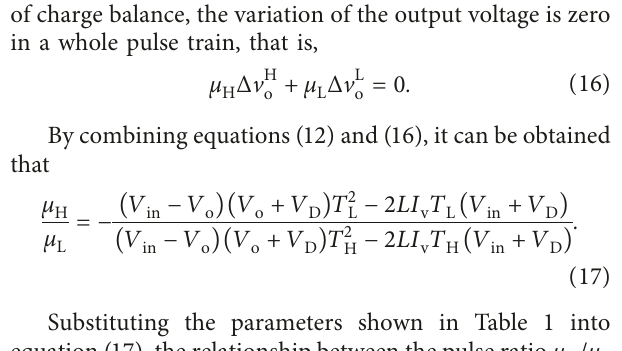
Figure 4: Pulse ratio versus input voltage of the DCPT-controlled buck